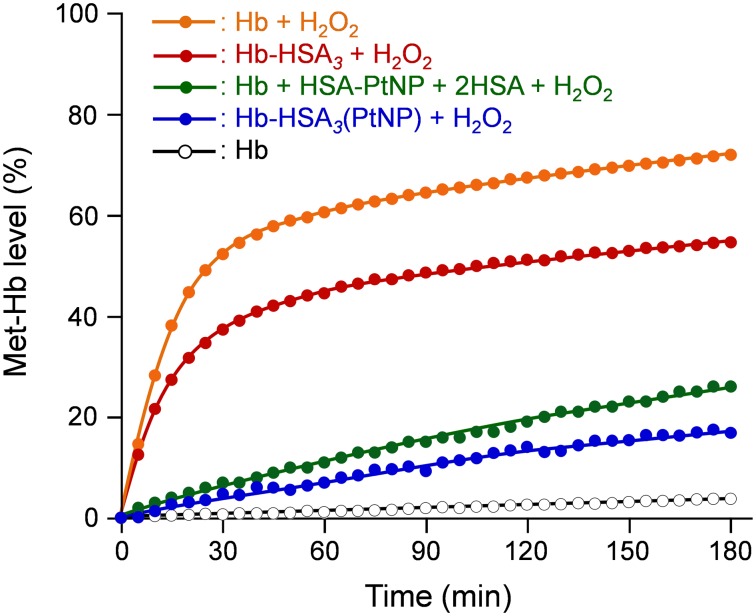
Time course of metHb level of Hb-HSA3 and Hb-HSA3(PtNP) clusters.[Hb] = 10 µM in 20 µM H2O2 solution at 25°C.